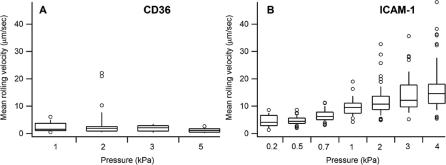
Changes in Rolling Velocities of iRBCs on Purified CD36 and ICAM-1Box and whisker plots are generated from tracking the average velocities of populations of individual cells rolling either on recombinant CD36 or on recombinant ICAM-1. The top and bottom of the box denote the 75th and 25th percentiles of the population, respectively, and the top and bottom of the whiskers denote the 90th and 10th percentiles, respectively. Outliers are marked with open circles.(A) Stabilization of rolling velocities of iRBCs on CD36. At pressures where rolling is observed on CD36, average rolling velocities of most cells remain stable at between approximately 1 and 3 μm/s. Difference between rolling velocities at all pressures was not statistically significant (ANOVA, p > 0.01). A few outliers are observed with higher rolling velocities (up to 22 μm/s) at 2 kPa.(B) Variation in rolling velocity on ICAM-1 at different pressures. Populations of iRBCs on ICAM-1 at different pressures showed inhomogeneity of variances (Levene's test, F = 12); thus, statistical significance of differences in means could not be evaluated. However, box and whisker plots show only a gradual increase in rolling velocity of most infected cells at higher flow pressures, and only higher velocity rollers increase rolling velocity in direct proportion to increased fluid pressures. At 4 kPa, the highest rolling velocity increased to 45 μm/s, from 32 μm/s at 3 kPa and 26 μm/s at 2 kPa. In contrast, the median rolling velocity only increased to 14.6 μm/s at 4 kPa from 12.1 μm/s at 3 kPa, 10.7 μm/s at 2 kPa, and 9.5 μm/s at 1 kPa.